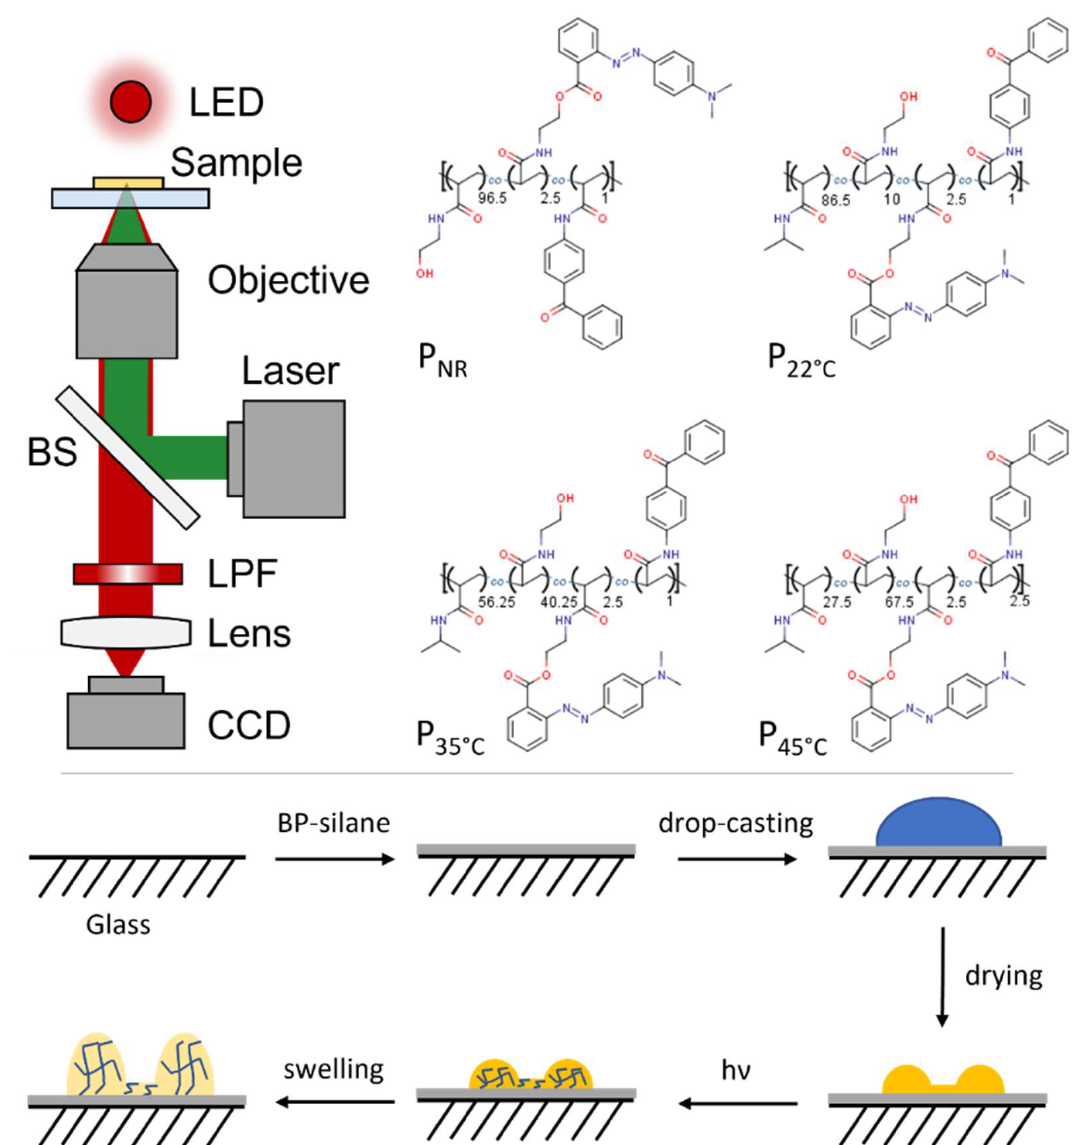
Figure 1. Top left : Sketch of the optical setup used in photoactuation experiments including laser, light-emitting diode (LED), objective, sample, dichroic beamsplitter (BS), longpass filter (LPF), lens, and charge-coupled device (CCD) camera; Top right : Structures and monomer feed composition of the different non-thermoresponsive (P NR ) and thermoresponsive copolymers (P 22°C , P 35°C , P 45°C ) em- ployed in this study; Bottom : Sample preparation process of o-methyl red-containing hydrogels for photoactuation experiments, involving functionalisation of the glass surface with a silane of the photocrosslinker benzophenone, drop-casting a solution of the respective copolymer, drying, pho- tocrosslinking, and subsequent